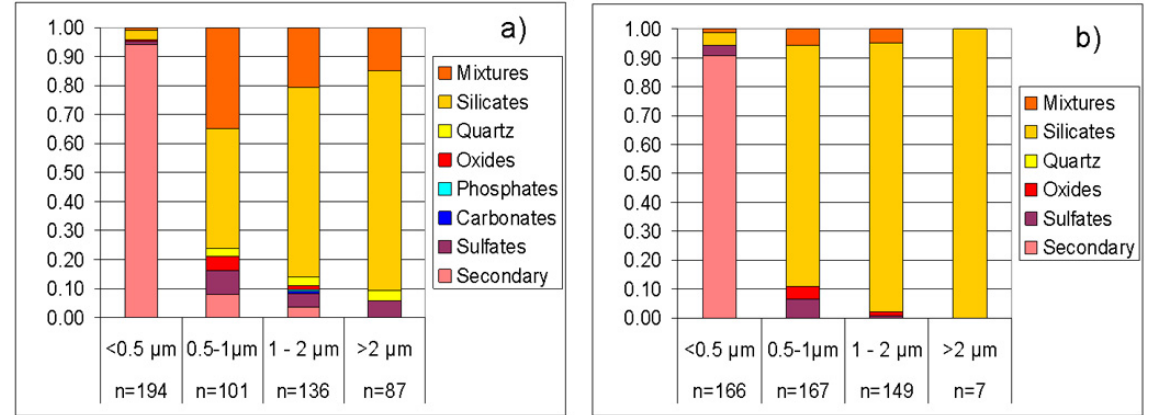
Fig. 6. Relative number abundance of particles with different chemical composition in different size bins for two sampling days ( (a) 15:01– 15:15UTC 2 May, (b) 16:20–16:24UTC 17 May). Here, n is the total number of particles analyzed in each size bin.